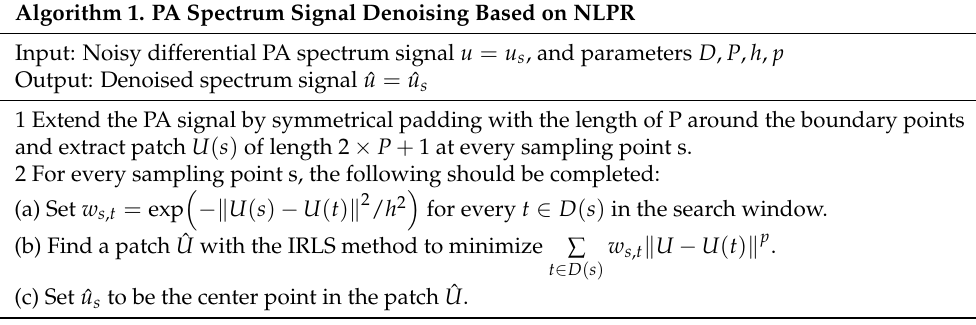
Table 1. PA spectrum signal denoising procedure based on NLPR algorithm. Algorithm 1. PA Spectrum Signal Denoising Based on